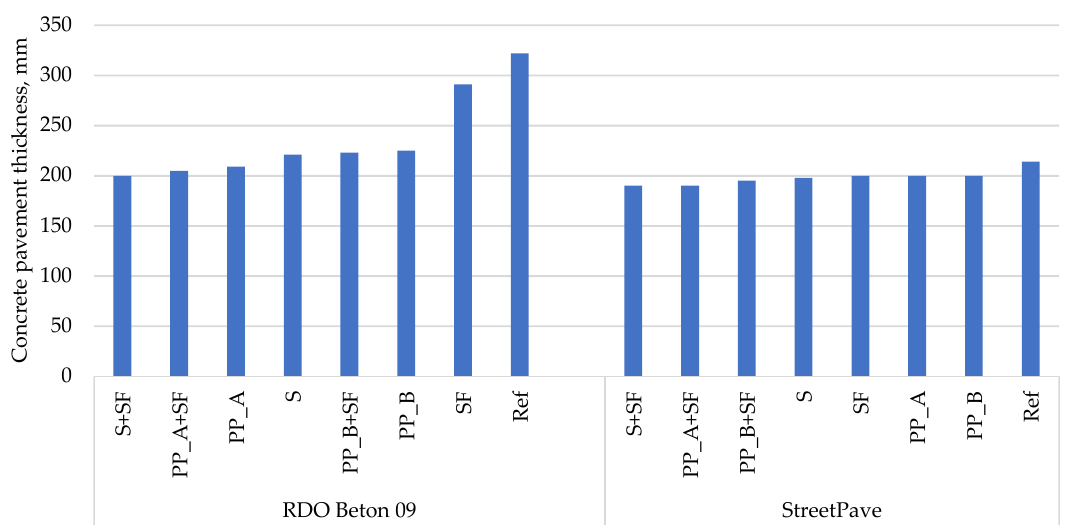
Figure 4. Calculated PCP thicknesses on crushed aggregates base.